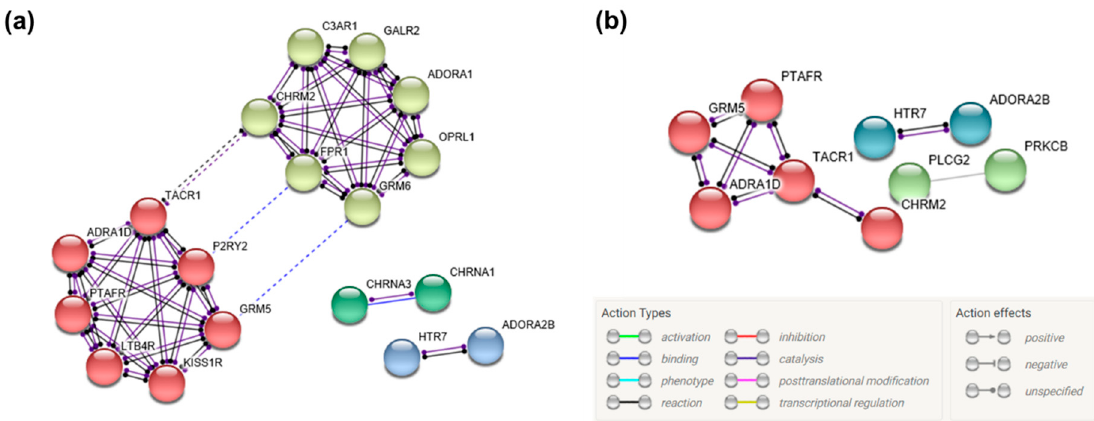
Figure 6. Gene network construction of DEGs involved in TC using Search Tool for the Retrieval of Interacting Genes (STRING). The minimum required interaction score was set as the highest confidence value (>0.900), and the inflation parameter was set to 3 for MCL clustering. ( a ) Gene networks of DEGs involved in neuroactive ligand – receptor interaction pathway. ( b ) Gene networks of DEGs involved in the calcium signaling pathway. Colored nodes represent query proteins and first shell of interactors.